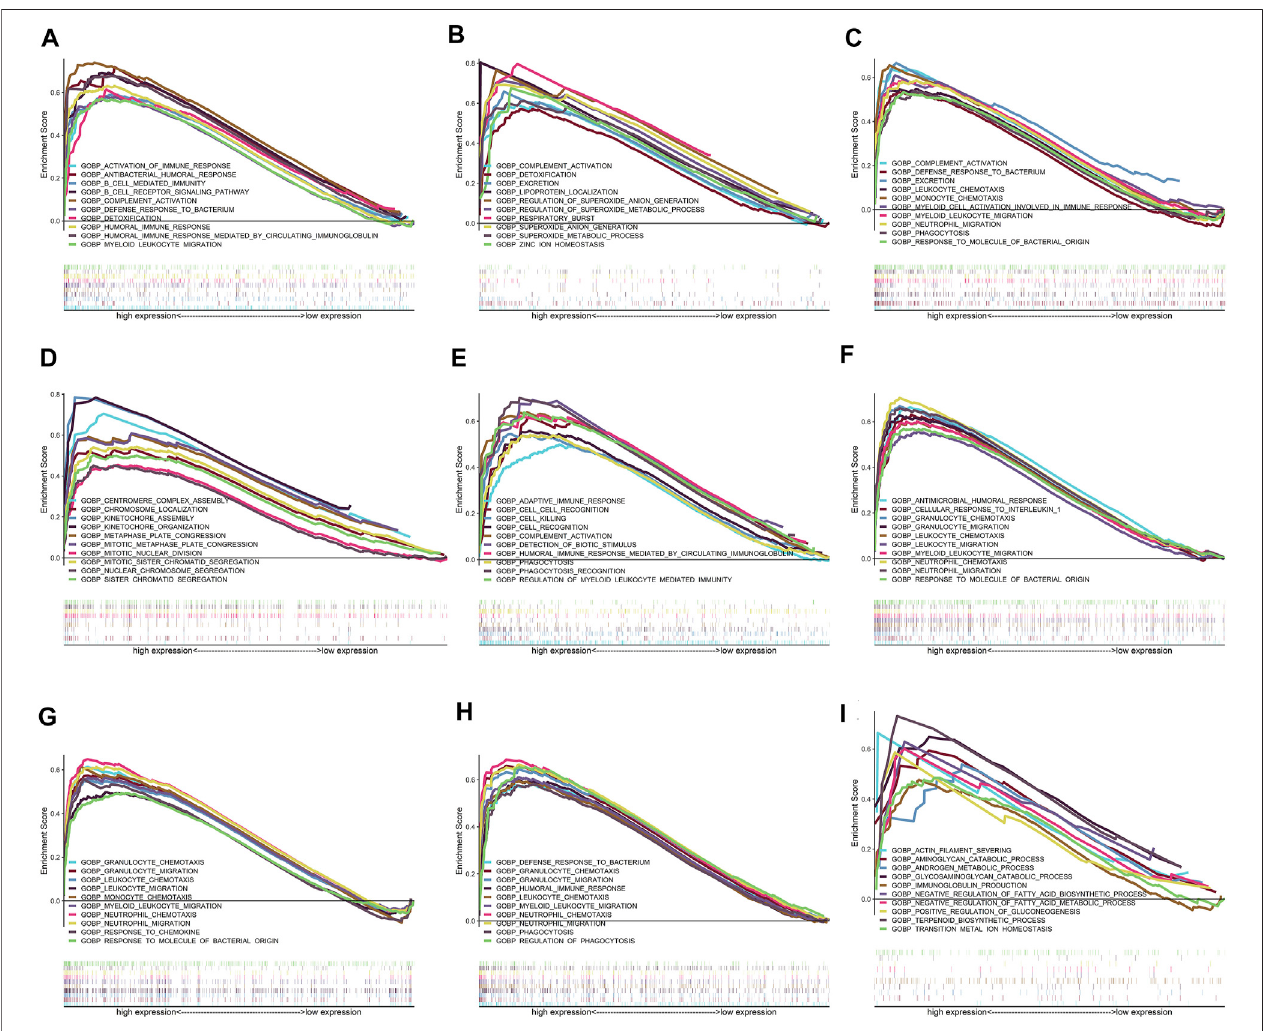
FIGURE 9 | Results of GSEA for the nine real hub genes. Only top 10 upregulated terms in high-expression groups of the nine real hub genes in IgAN cases are exhibited. (A – I) Top 10 upregulated GO-BP terms in the high-expression group of CSF1R, CYBB, FPR3, GPR65, HCLS1, IL10RA, PLA2G7, TYROBP, and VSIG4 in